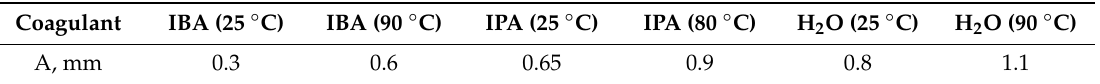
Table 2. Positions of the coagulation front (A) at 1 min after contacting for different coagulants at various temperatures.